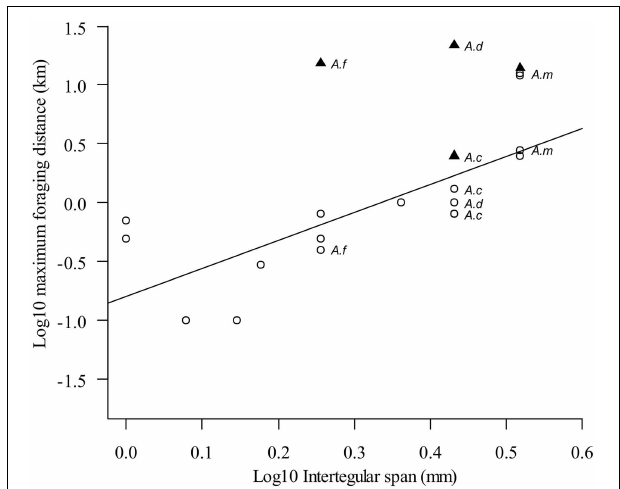
FIGURE 1 | Larger bees are capable of foraging at greater distances, but dance data indicates that honey bees forage further than predicted from their body size. White circles indicate maximum ranges from feeder training experiments analyzed in Greenleaf et al. (2007). Black triangles indicate maximum ranges from dances to natural foraging sites from Dyer and Seeley (1991) for A. cerana , A. dorsata, and A. florea and Beekman and Ratnieks (2000) for A. mellifera . Dance data indicate that all members of the genus Apis forage further than predicted by their body size. Reproduction of Figure 1b from Greenleaf et al. (2007) with